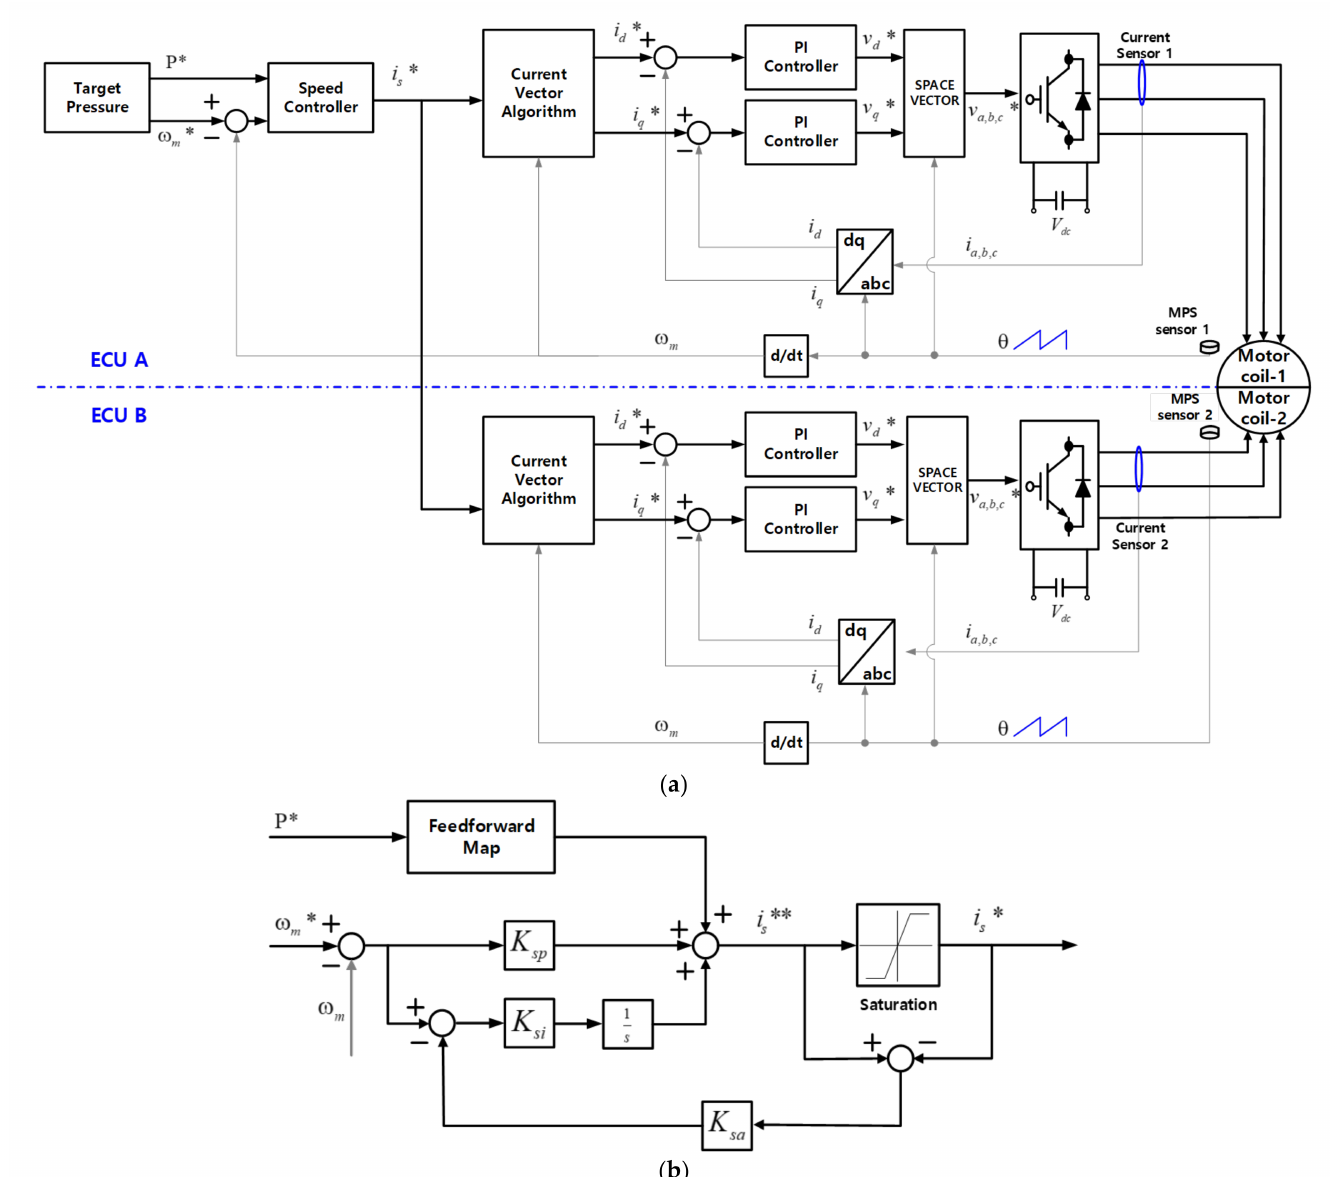
Figure 7. Proposed motor current control method for generating brake pressure: ( a ) functional block diagram for current control of the DW-PMSM; ( b ) functional block diagram for the proposed speed